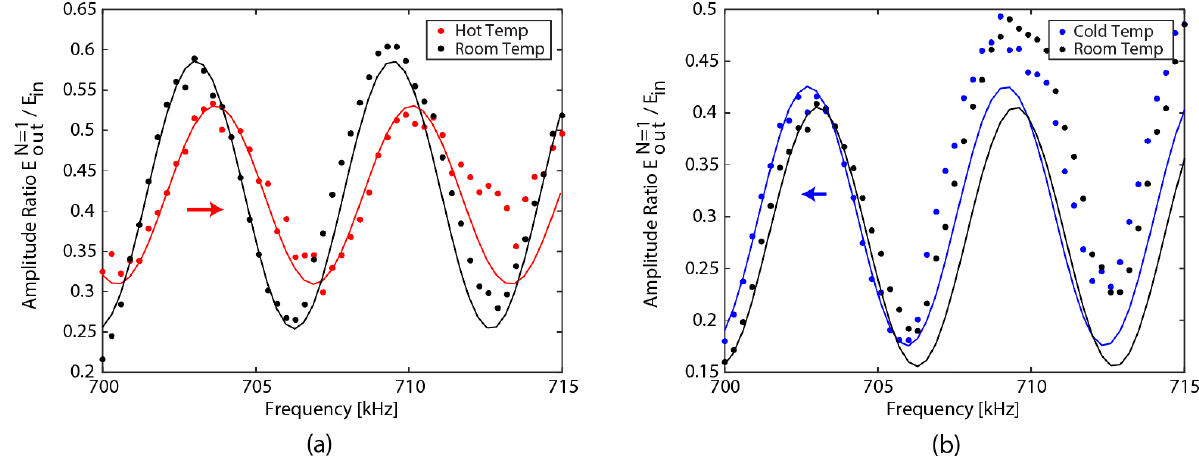
Figure 7. Wave interference pattern and fitted curves from 700 kHz to 715 kHz: ( a ) at room temperature and the hot temperature, and ( b ) at room temperature and the cold temperature.